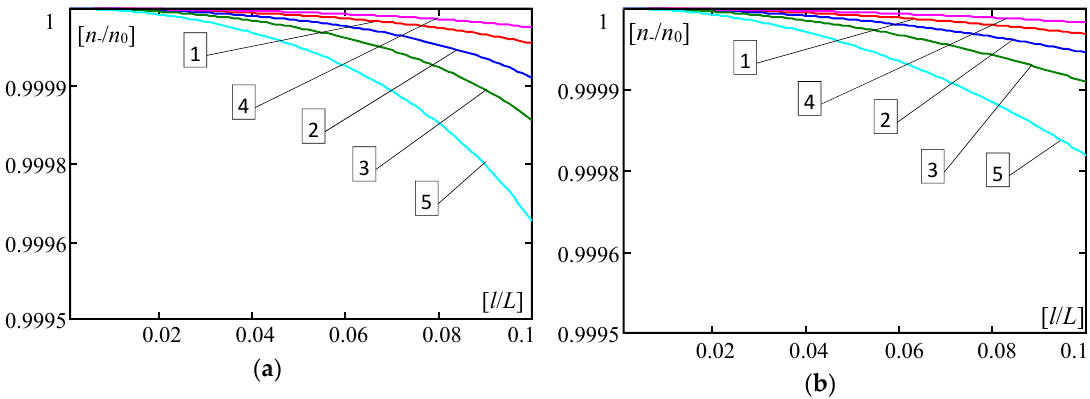
Figure 5. Values of ratios n _ / n 0 versus l / L ( E ”/ E ’ = 0.5, d / L = 0.01, m = 1). ( a ) For κ = 0.0001; ( b ) For κ = 0.000001. (1— γ by (28) 1 , 2— γ by (28) 2 , 3— γ by (28) 3 , 4— γ by (28) 4 , 5— γ by (29)).